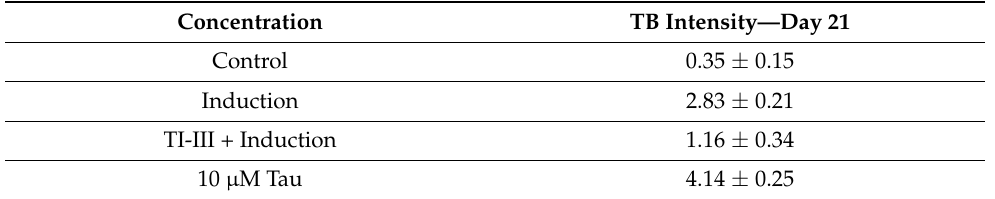
Table 8. Relative gene expression of chondrogenesis related genes (fold change).